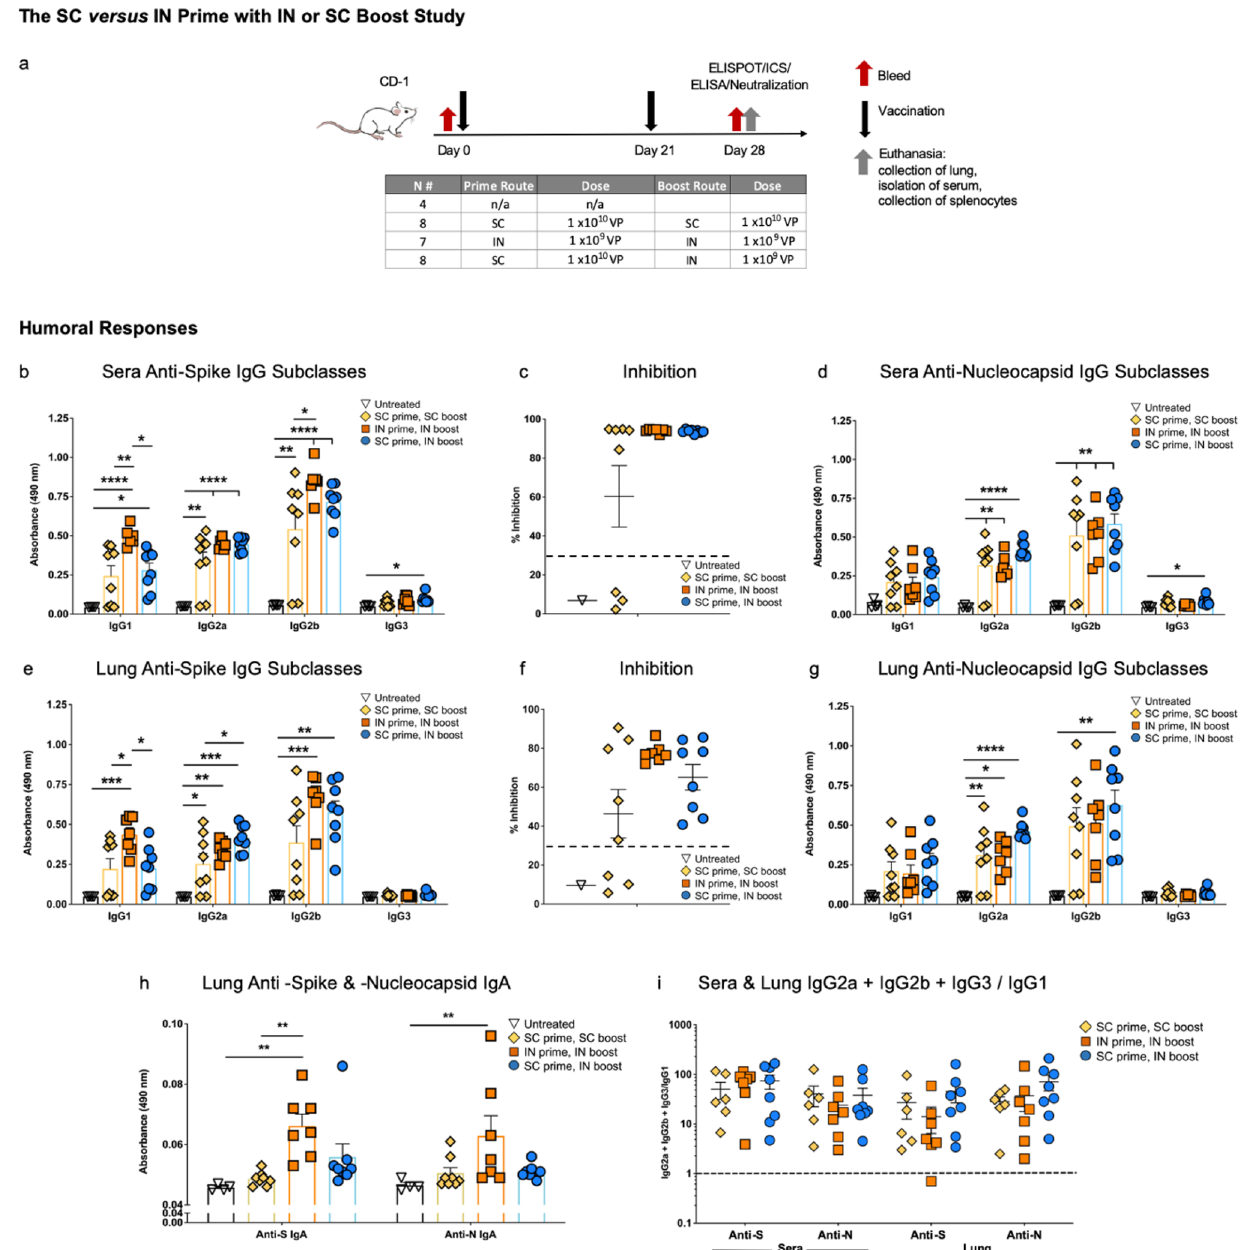
Figure 4. Humoral responses in the SC versus IN prime with SC or IN boost study . ( a ) CD-1 mice were untreated (n = 4) or received an SC prime, SC boost (n = 8); IN prime, IN boost (n = 7); or SC prime, IN boost (n = 8). ( b ) Sera anti-S antibodies by subclass (dilution 1:30) are shown as well as ( c ) percent inhibition in the surrogate neutralization assay where inhibition of 30% (dashed line) or greater is correlated with neutralization of live virus. ( d ) Sera anti-N IgG by subclass (dilution 1:270). ( e ) Lung homogenate anti-S IgG by subclass (dilution 1:30), ( f ) inhibition in the surrogate assay, and ( g ) anti-N IgG by subclass (dilution 1:30). ( h ) Lung homogenate anti-S and anti-N IgA. ( i ) The IgG2a + IgG2b + IgG3/IgG1 ratio for sera and lung anti-S and anti-N antibodies where values greater than 1 (dashed line) indicate Th1 bias. The ratio is not represented for mice with very low antibody production. Statistical analyses performed using One-way ANOVA with Tukey’s post-hoc analysis comparing each group to every other group where * p < 0.05; ** p ≤ 0.01; *** p ≤ 0.001; and **** p ≤ 0.0001. Data graphed as the mean with